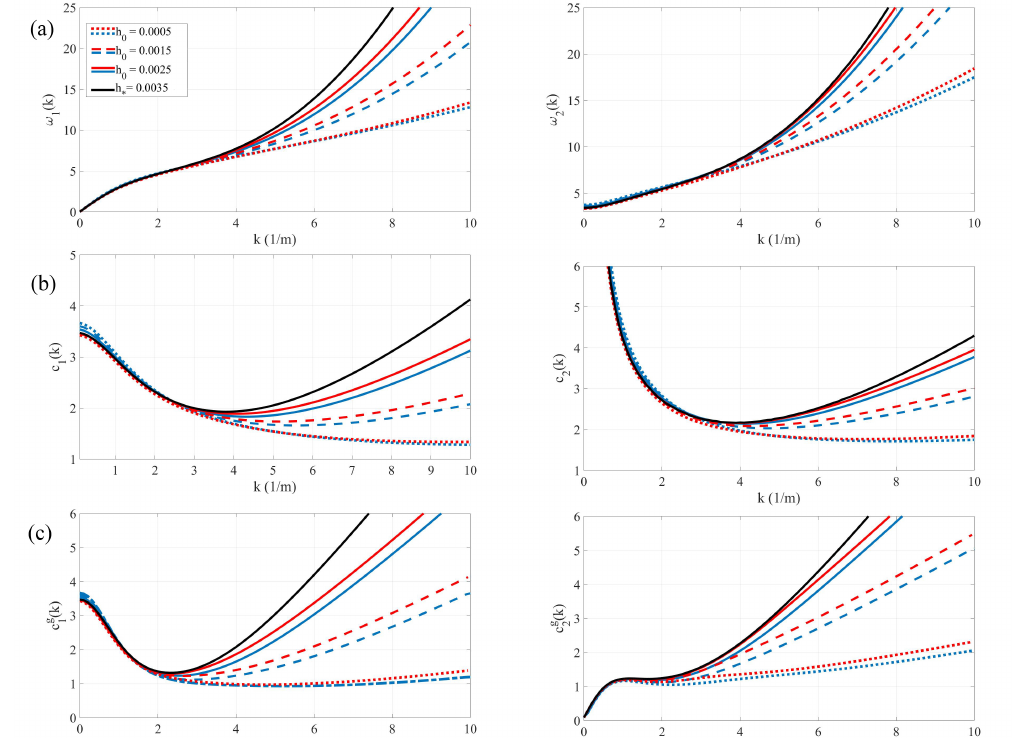
Figure 4. Dispersion relations ( a ), phase ( b ) and group ( c ) speeds of the first ( left ) and second ( right ) modes for different values of h 0 . Red lines show the results for Case 1, blue—for Case 2. The black line shows the results for the plate with constant thickness equal to h ∗ = 0.0035